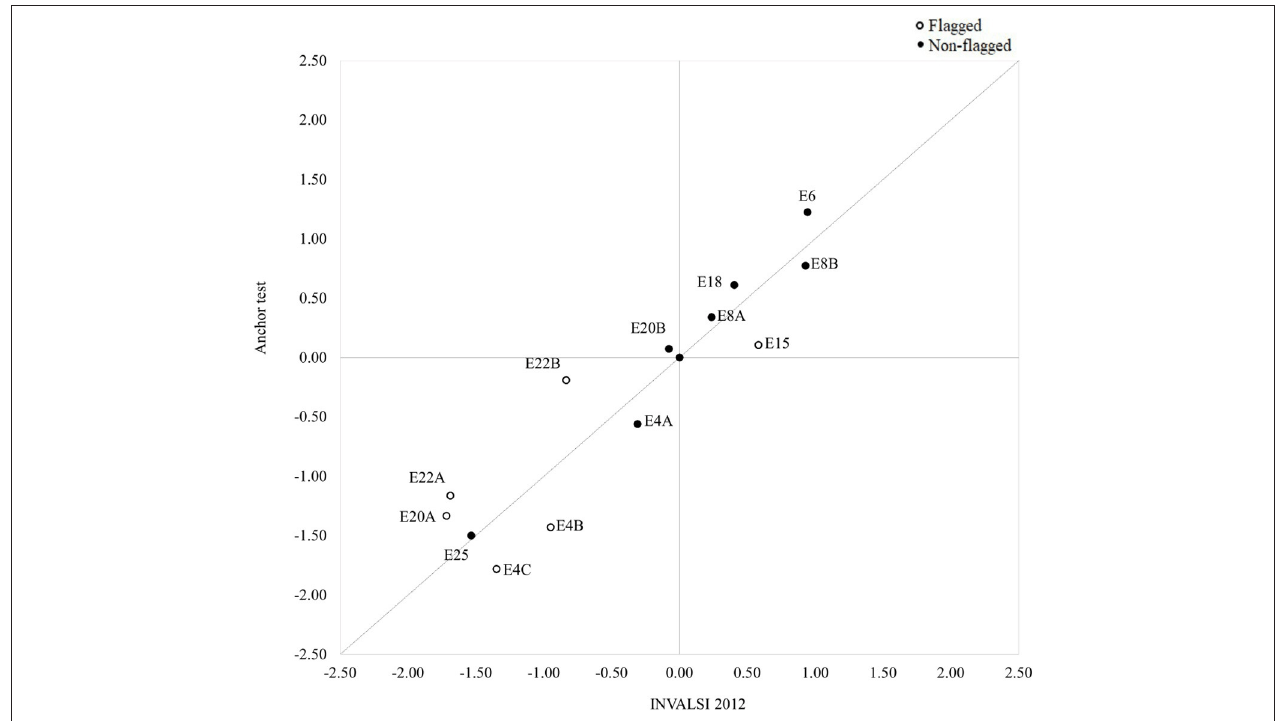
FIGURE 4 | Cross-plot: Difficulty (logit) of common items as estimated in the INVALSI [35] and anchor test forms (full set: r = 0.93; reduced set: r =